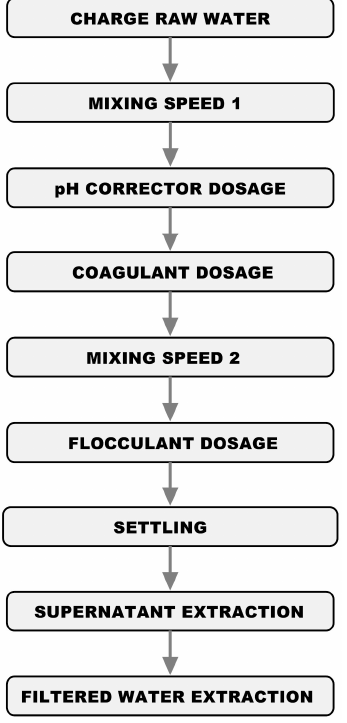
Figure 1. Flowchart of the JT procedure.